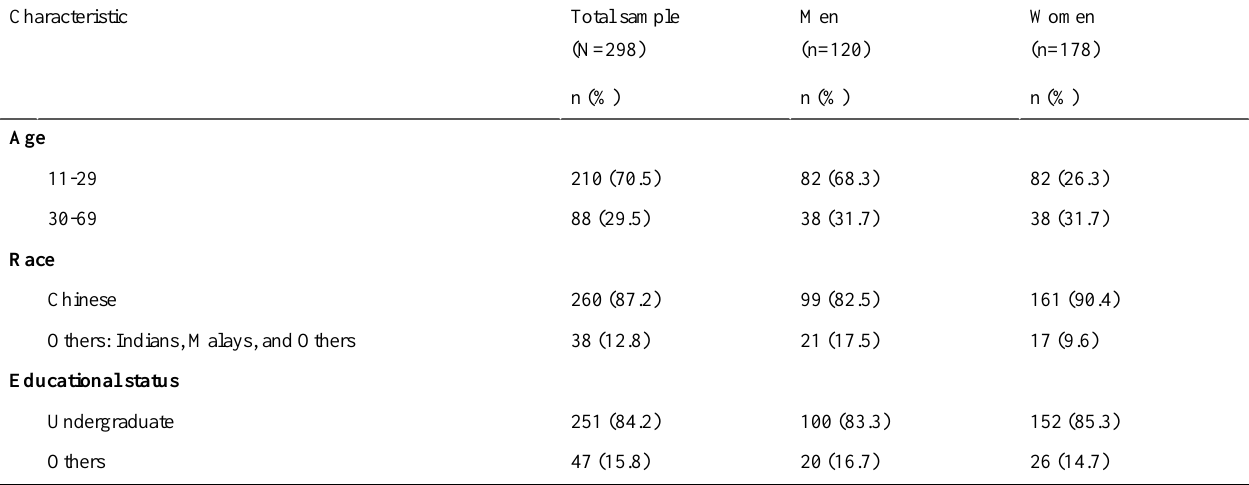
Table 1. Demographic characteristic of respondents